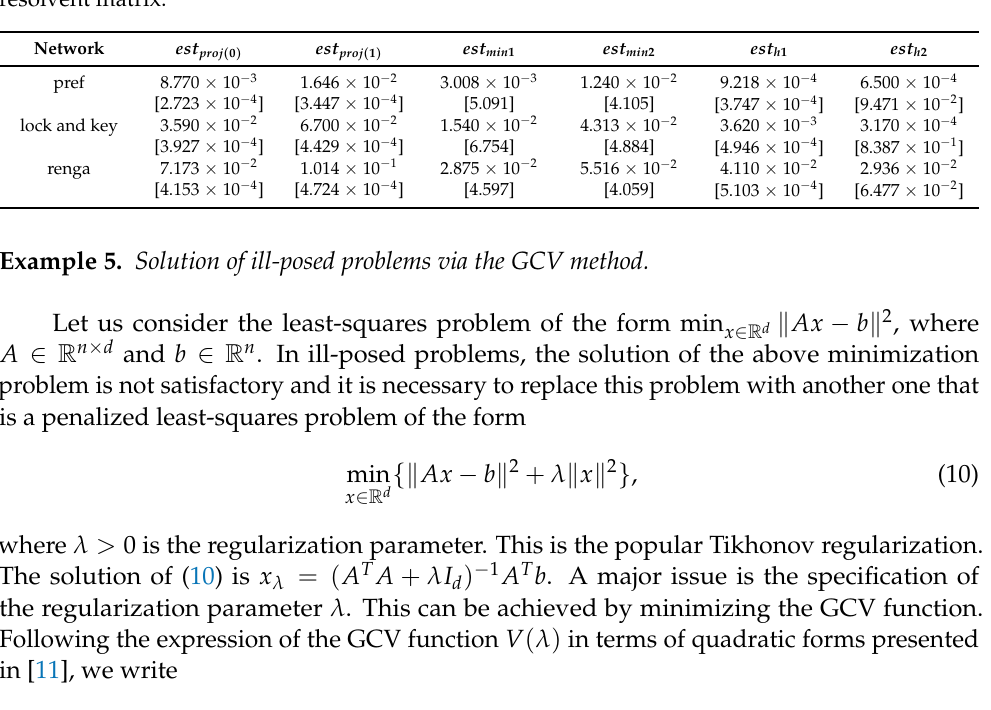
Table 5. Mean relative errors and execution times (seconds) for estimating the diagonal of the resolvent